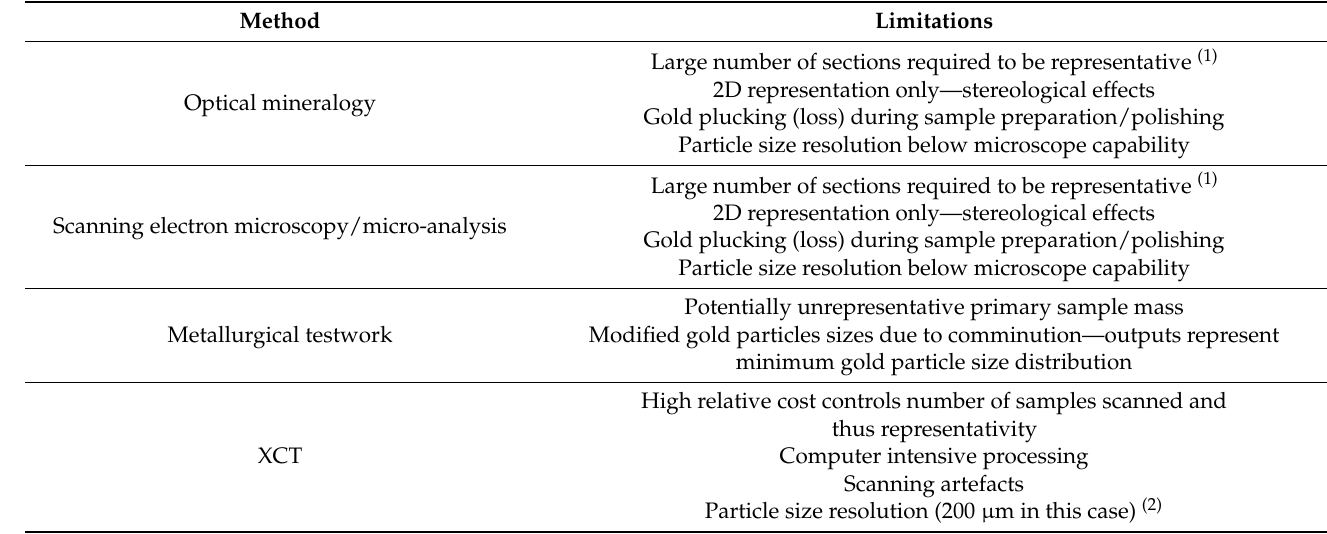
Table 11. Limitations of analytical/testwork methods used in this